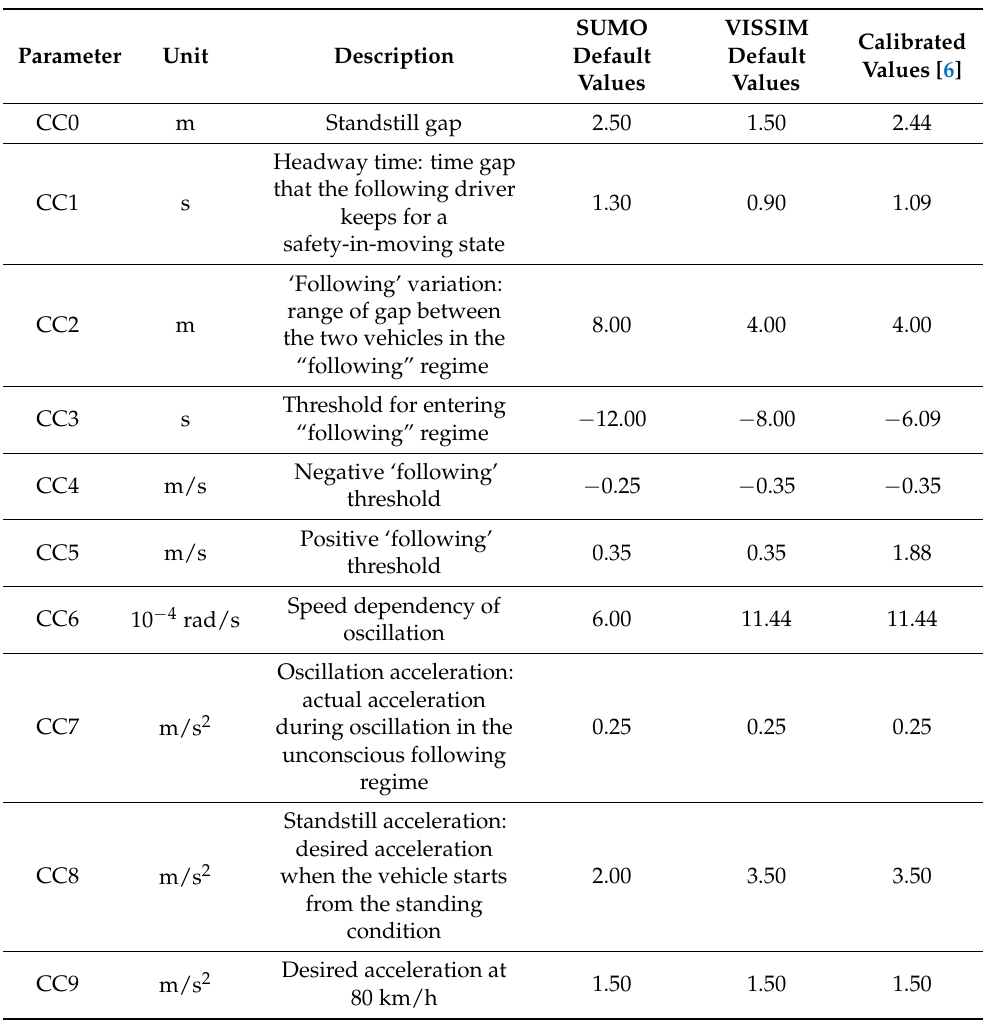
Table 1. Wiedemann-99